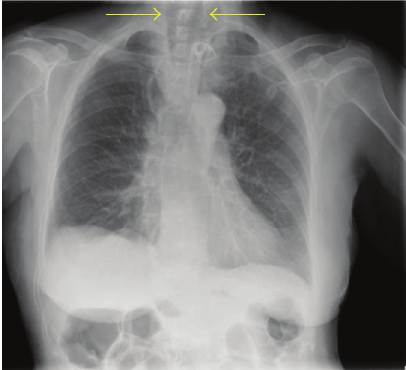
Figure 1: Chest radiograph showing large air shadow in the neck.